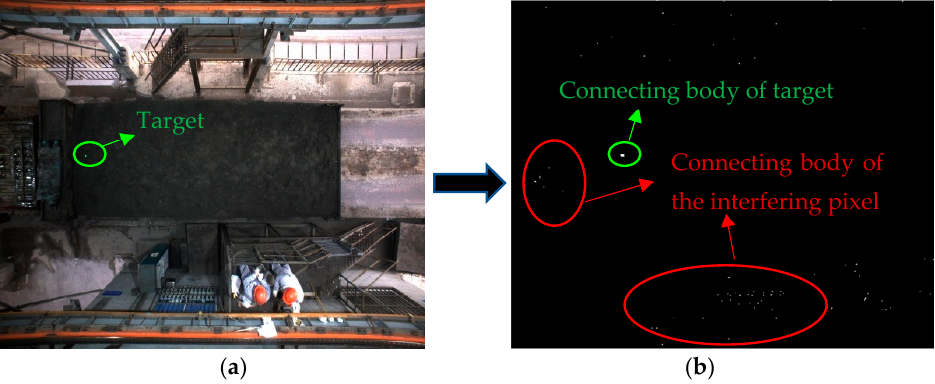
Figure 21. Binary image obtained via the maximum interclass variance method. ( a ) Original image. ( b ) Binary image.